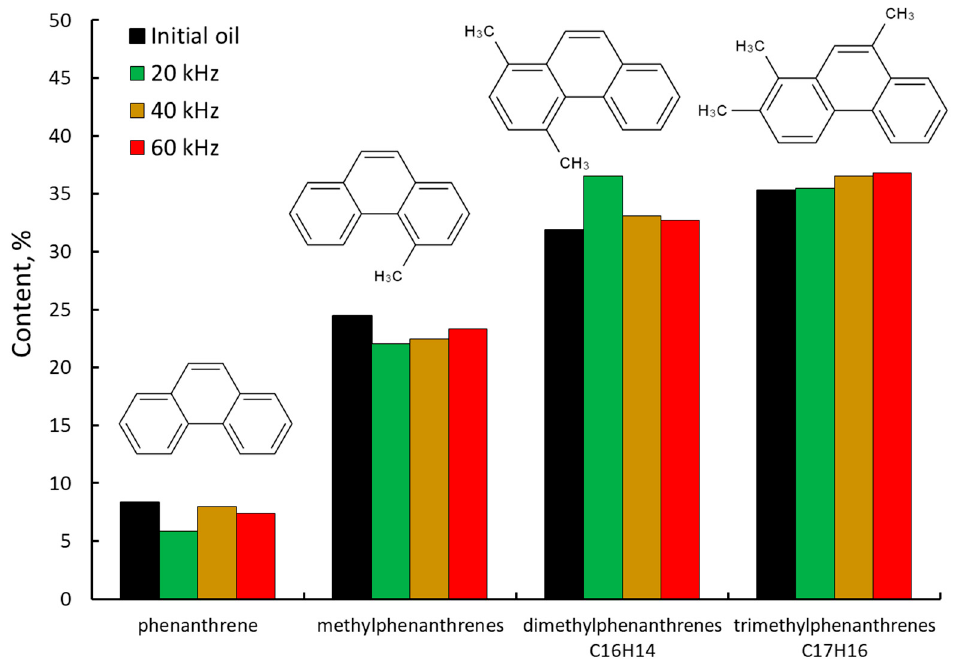
Figure 7. The relative content of phenanthrenes in the composition of aromatics fractions of initial sample and sonicated oil samples under various wave oil sample and sonicated oil samples under various wave frequencies .